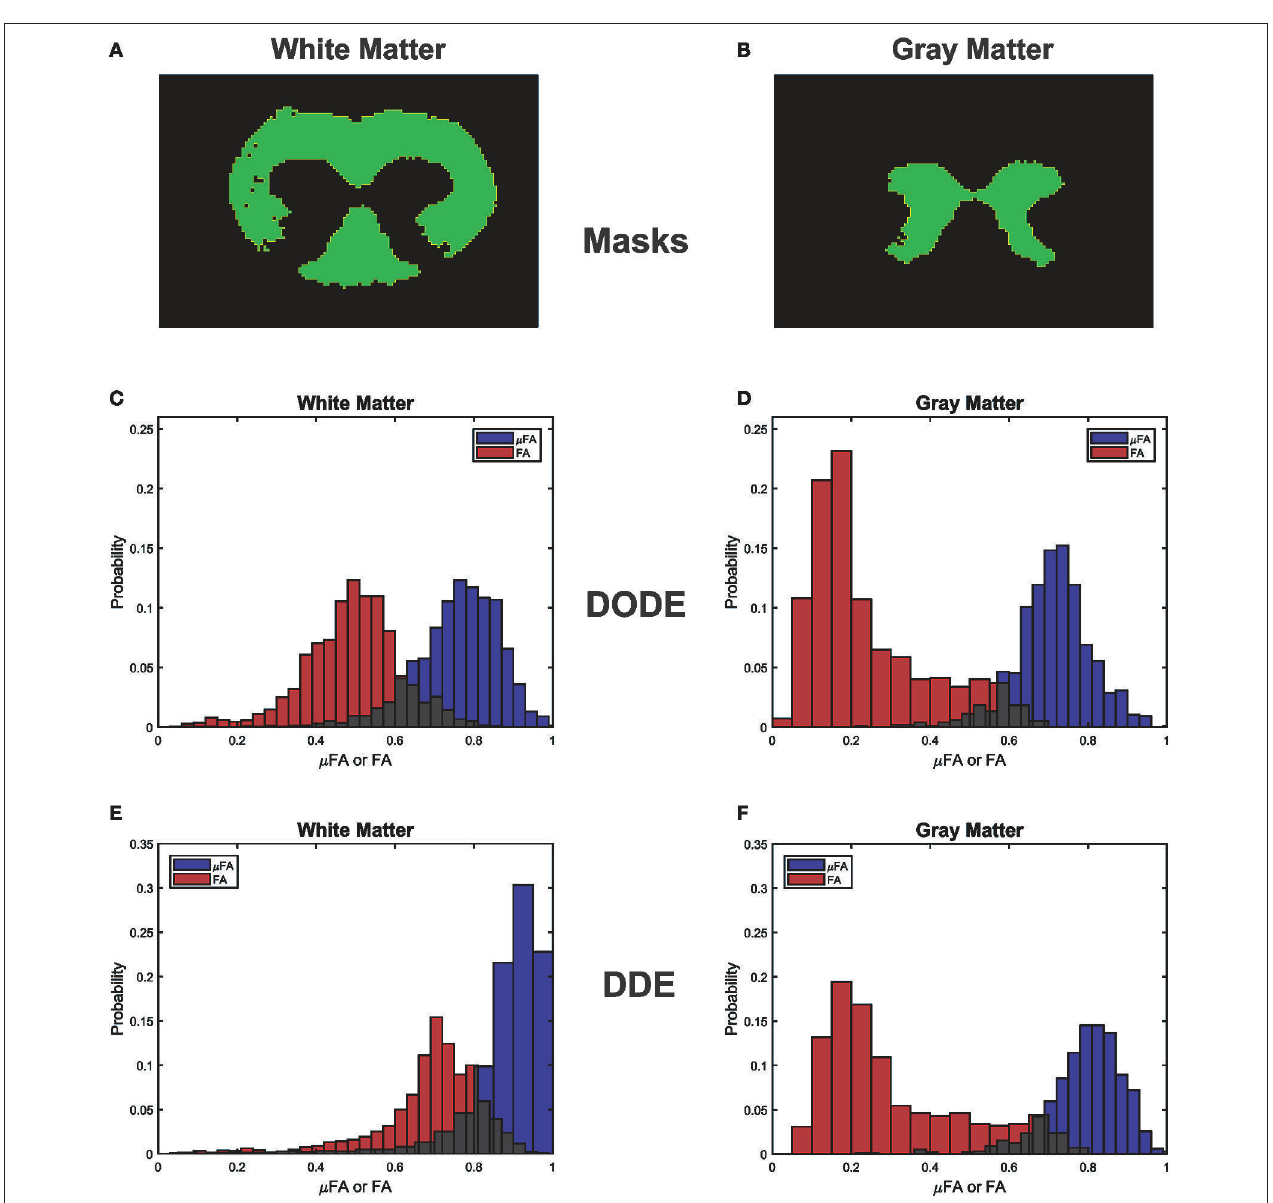
FIGURE 4 | Histogram distributions of the different metrics in white matter and gray matter. (A,B) Masks for the white and gray matter tissues, respectively. (C,D) µ FA DODE and FA DODE for white and gray matter. (E,F) µ FA DDE and FA DDE for white and gray matter. Notice the different distributions in white matter for both DODE- and DDE-driven metrics, as well as the higher µ FA as compared to FA in all